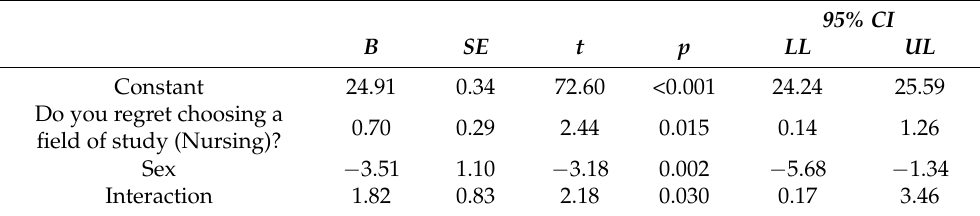
Table 3. Regression coefficients for the model considering the moderating role of sex for the relation- ship between regret choosing a field of study and stress.